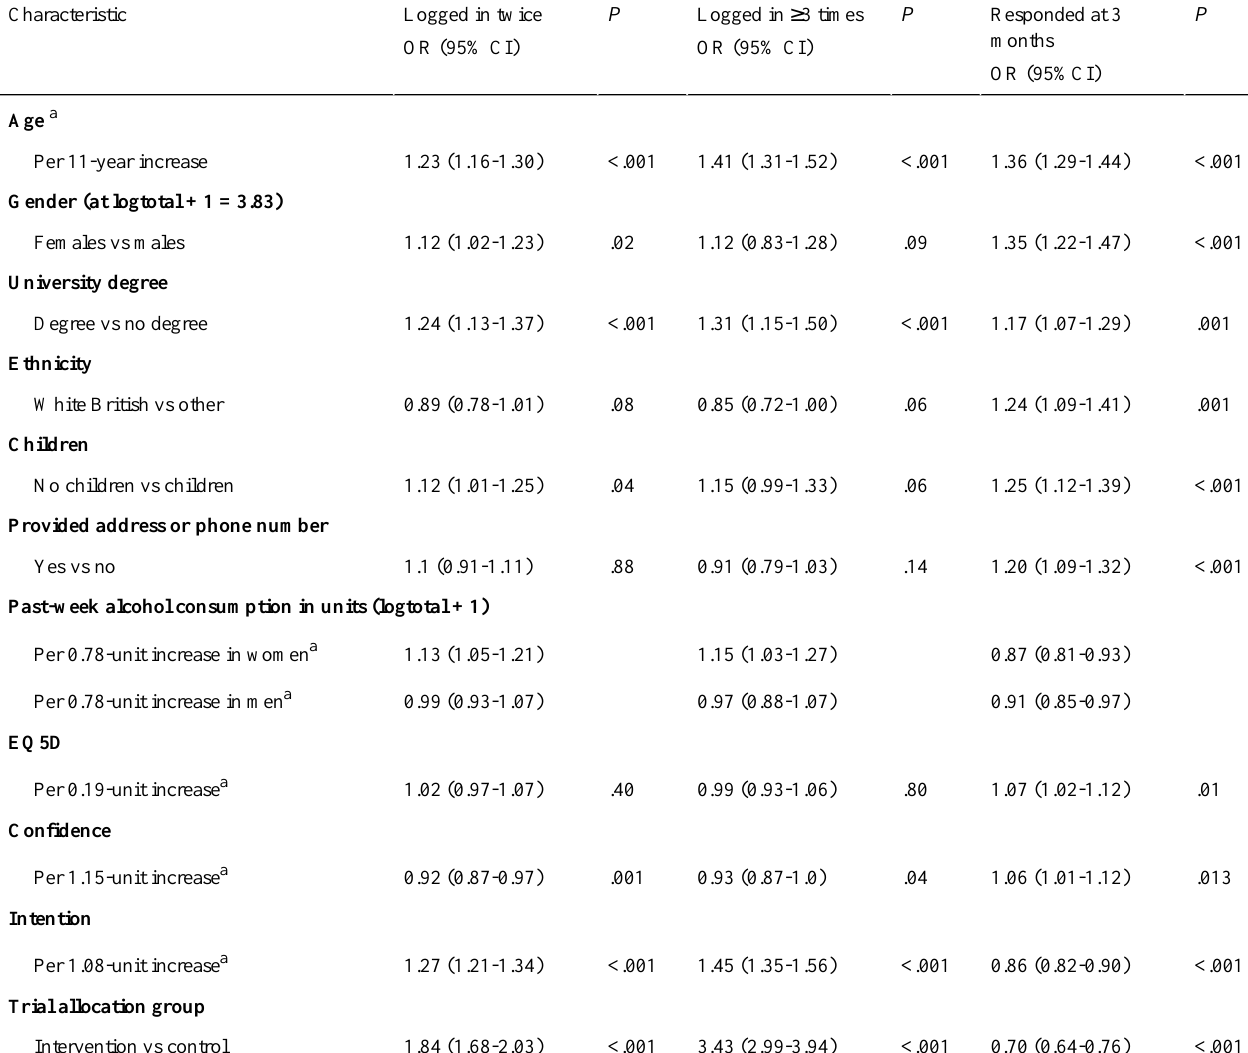
Table 3. Baseline predictors of adherence and